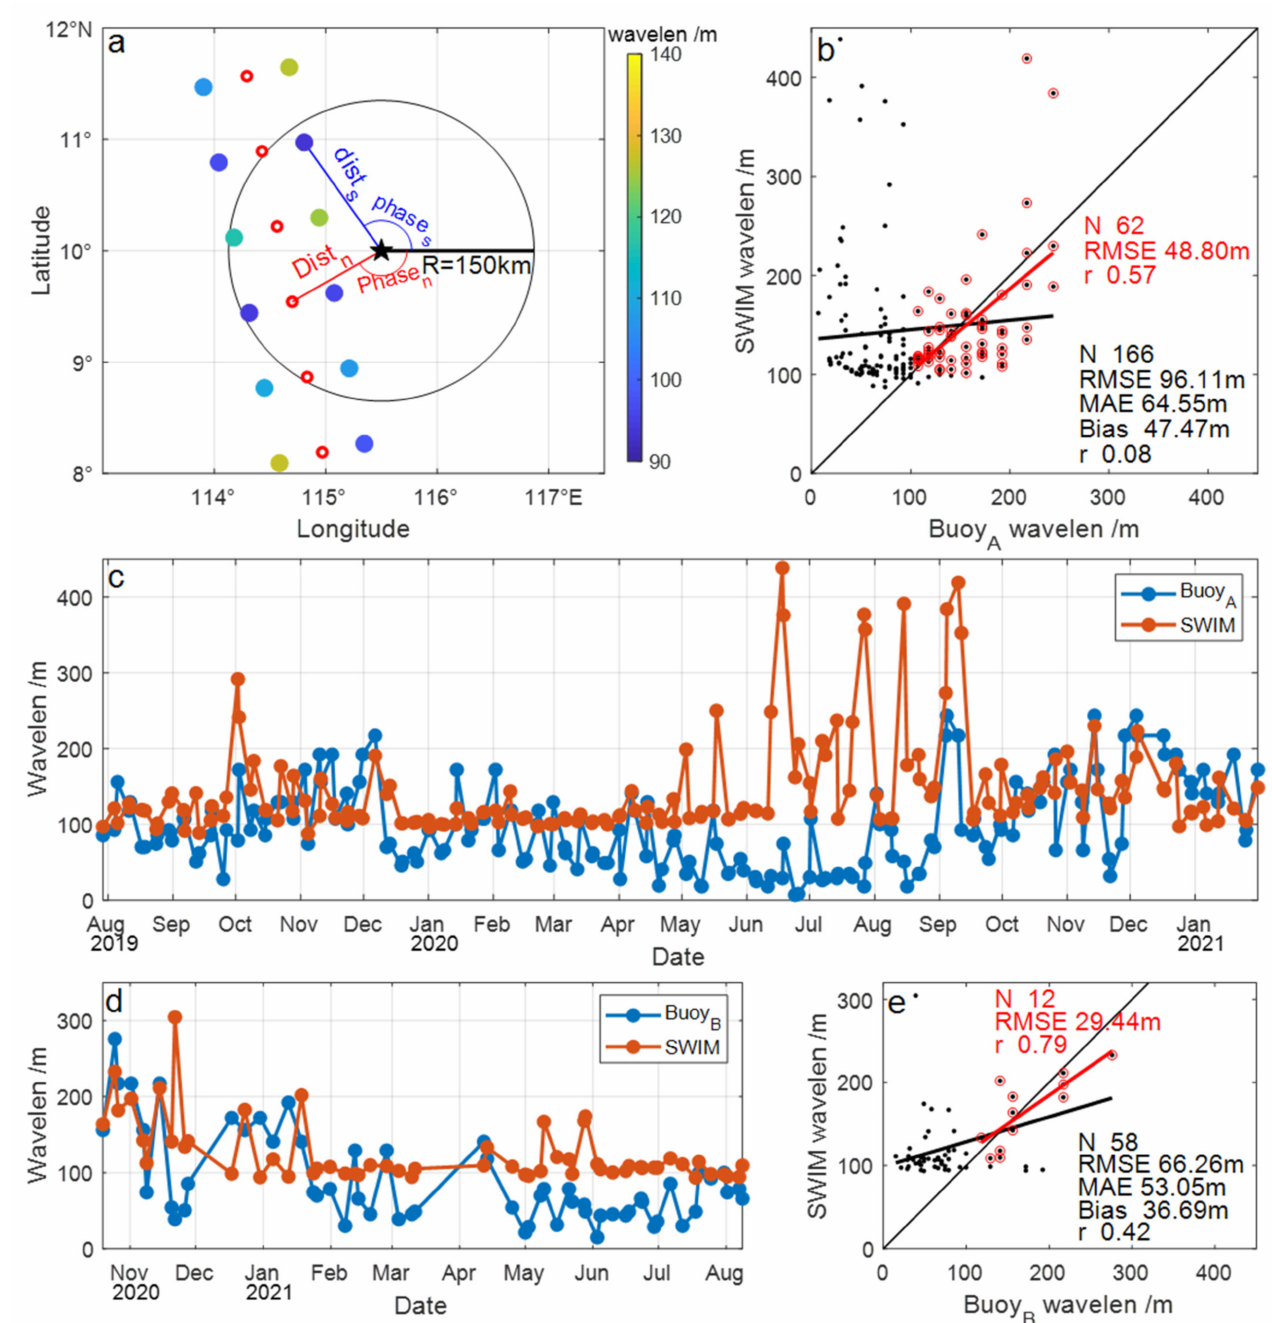
Figure 2. Space collocation and comparisons of the dominant wavelengths of CFOSAT and buoys; ( a ) shows the spatial matching results of position information recorded by buoy A and satellite data on 25 January 2021. The dark pentagram indicates the buoy position. The colored dots and the red circles represent the measuring points of the wave spectrum and the nadir beam, respectively; ( b , c ) show the comparison of dominant wavelengths from buoy A and CFOSAT in the forms of scatterplots and time series, respectively. ( d , e ) show the comparison of dominant wavelengths from buoy B and CFOSAT in the forms of time-series and scatterplots, respectively. The linear fitting curve, the sequence length (N), RMSE, mean absolute error (MAE), standard deviation (STD), and correlation coefficient (r) of the SWIM-observed dominant wavelengths are illustrated in black in ( b , e ). The scatters, curves, and legends in red in ( b , e ) are calculated from wavelengths exceeding 100